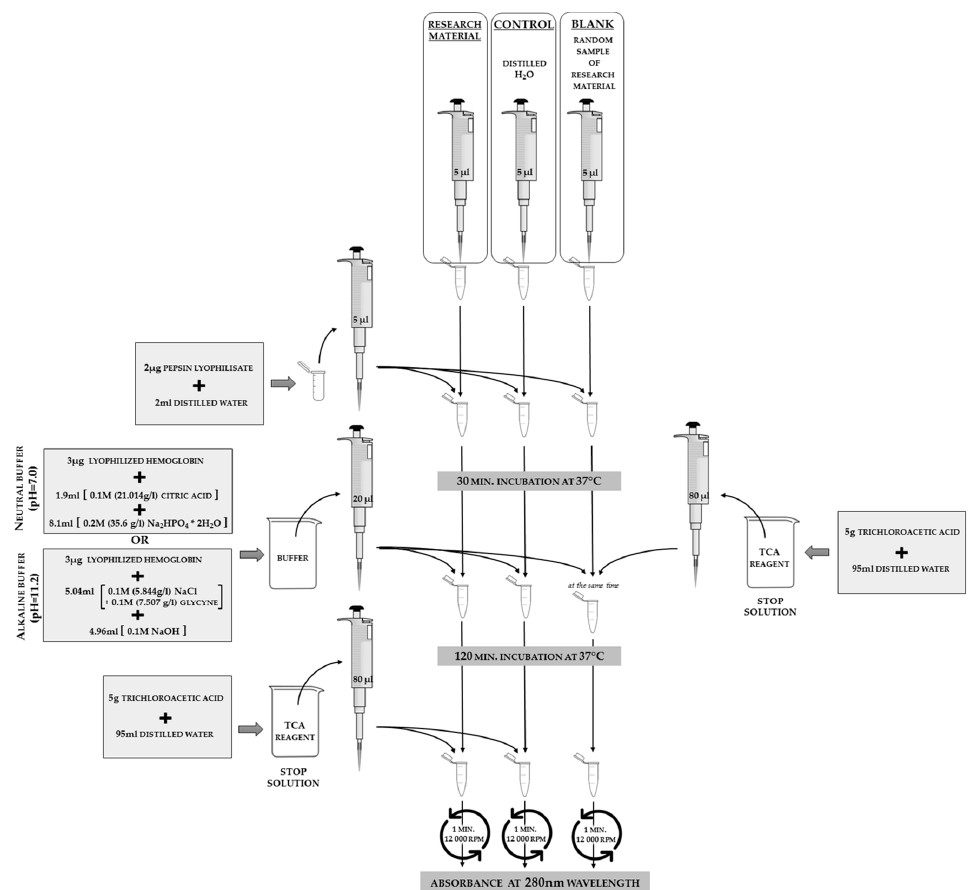
Figure 9. The scheme of neutral (7.0 pH) and alkaline (11.2 pH) protease inhibitor activity analyses